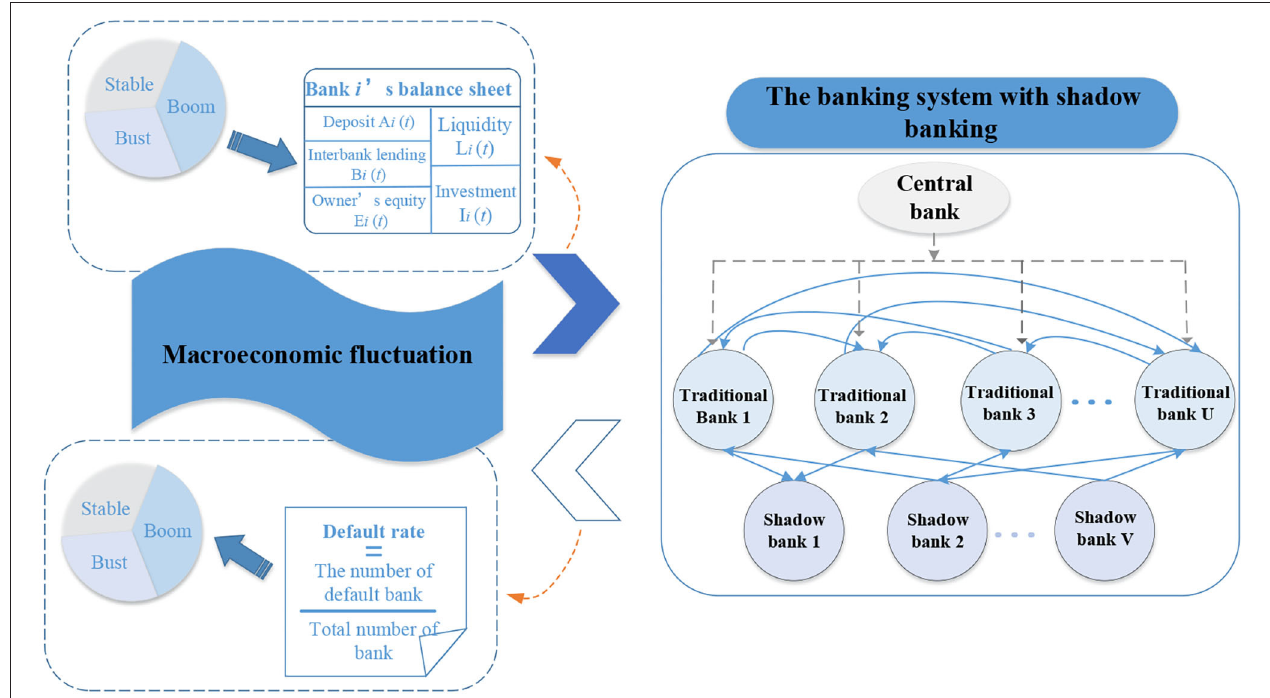
FIGURE 1 | The structure of the banking system with shadow banking under macroeconomic